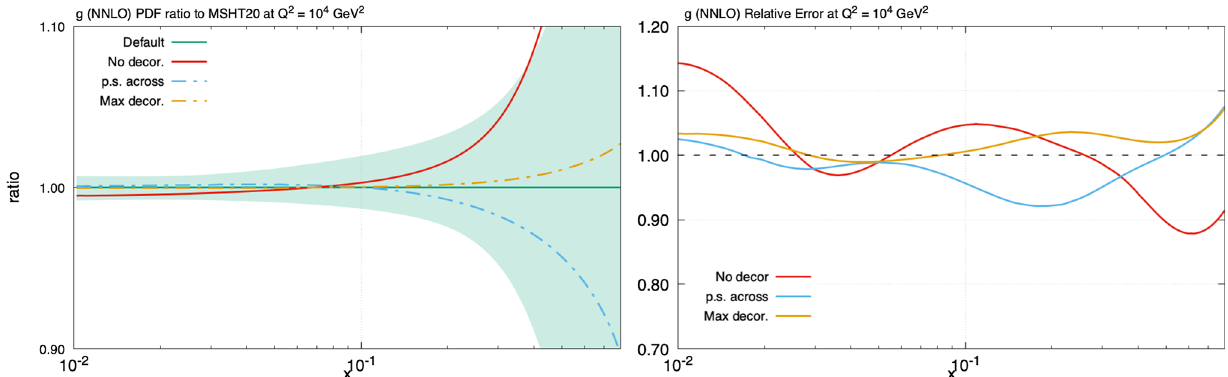
Fig. 13 (Left) Ratio of gluon PDFs to MSHT20 baseline, with α S free, at NNLO at Q 2 = 10 4 GeV 2 . The result of simultaneous fits to four absolute distributions within the ATLAS 8 TeV single differential top quark data set are shown: with no systematic error decorrelation